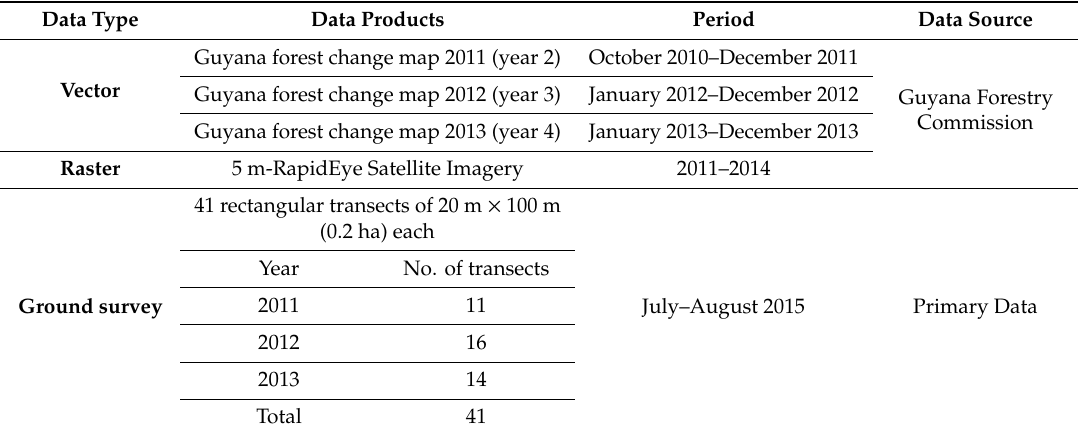
Table 1. Description of the datasets collected from Guyana Forestry Commission and from the field surveys, used for the mining degradation study. The years in the parenthesis indicate the assessment periods indicated in the Guyana Monitoring, Reporting, and Verification System (MRVS)